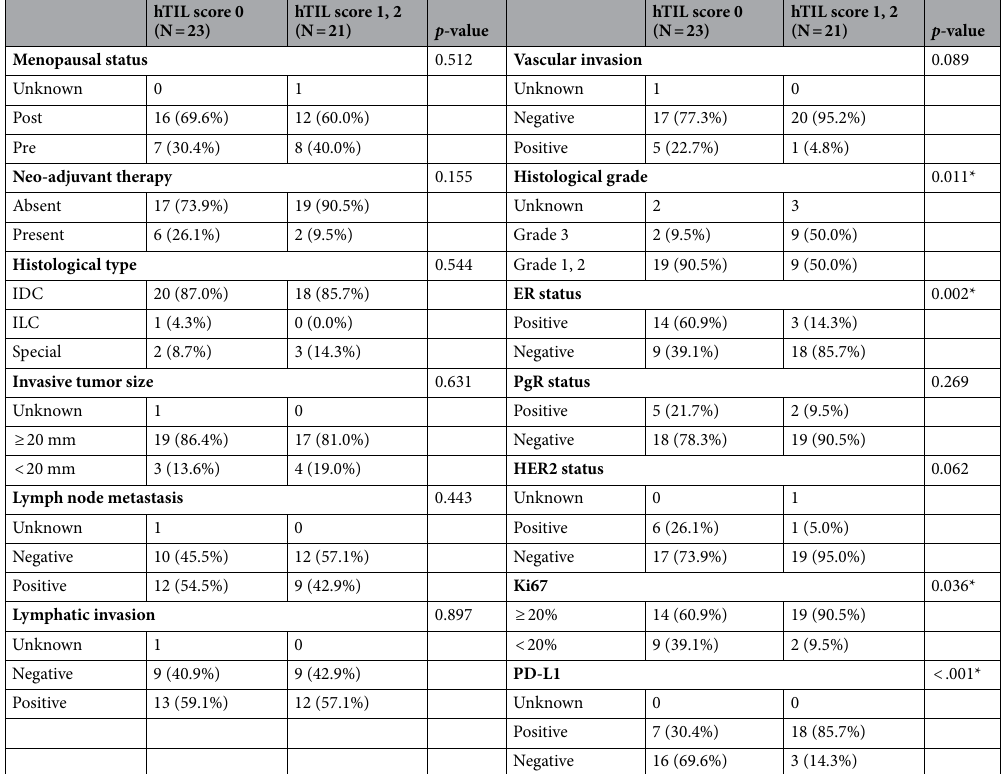
Table 1. Clinico-pathological characteristics by hTIL score. *Statistically significant p